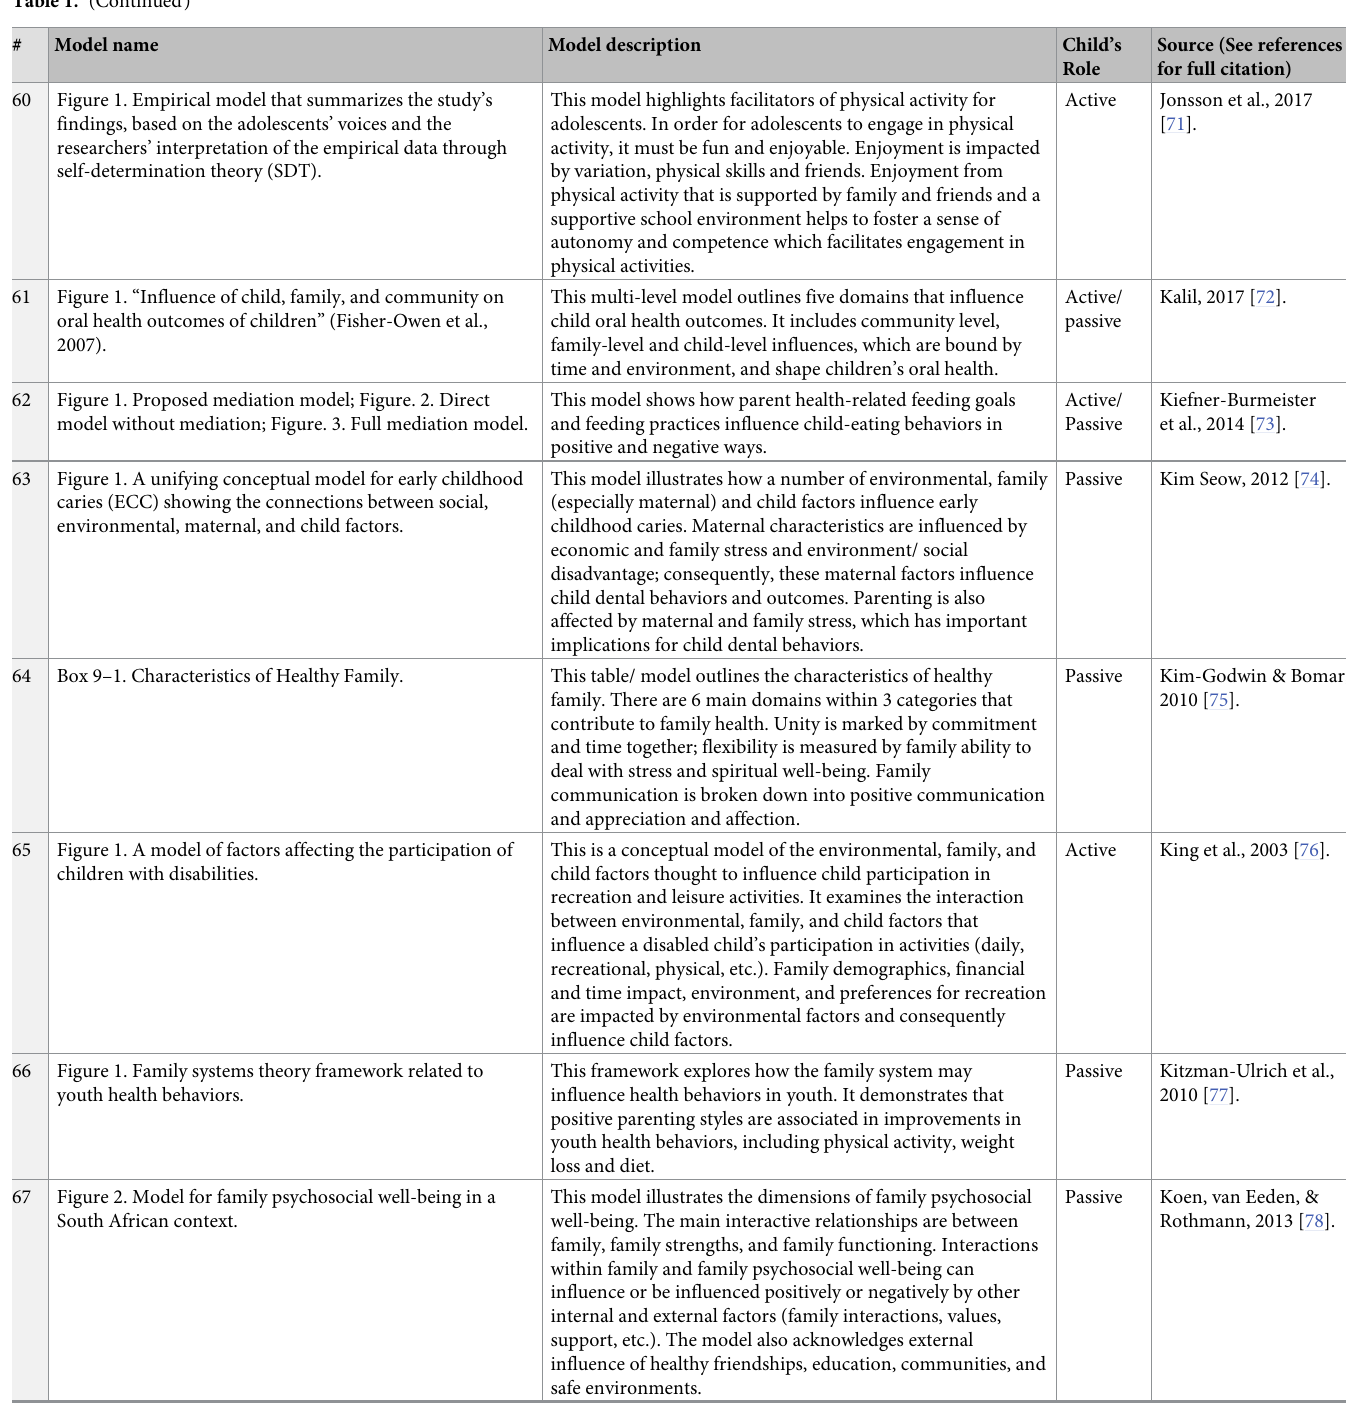
Figure 1. Empirical model that summarizes the study’s findings, based on the adolescents’ voices and the researchers’ interpretation of the empirical data through self-determination theory (SDT).